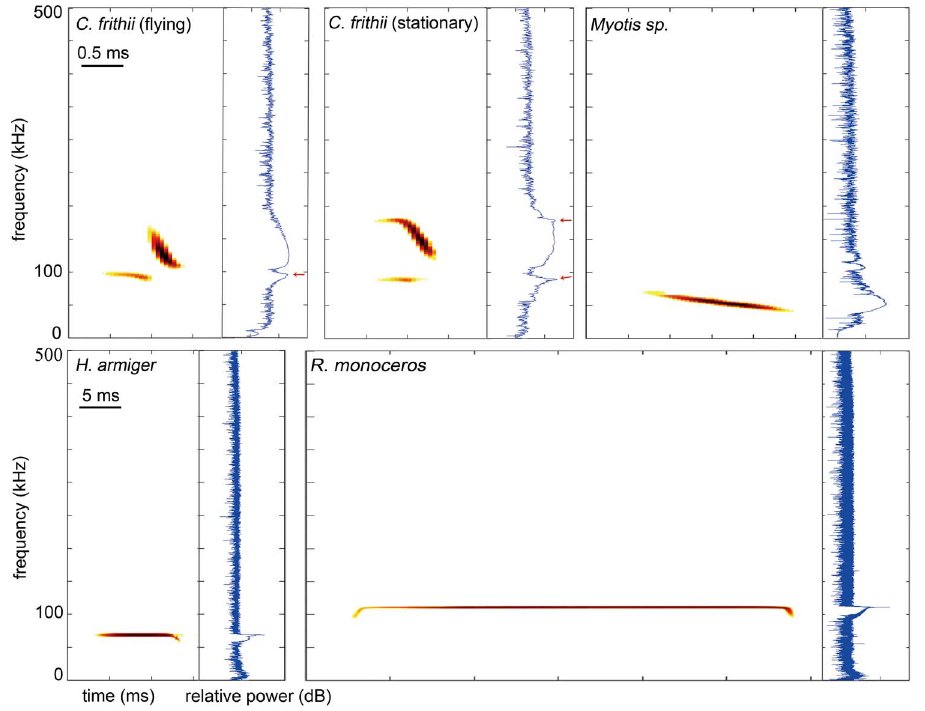
Figure 1. Spectrograms and power spectra illustrating the echolocation calls of Coelopsfrithii , Myotis sp., Hipposiderosarmiger , and Rhinolophusmonoceros . Arrows indicate the energy peak of the narrowband components of C. frithii calls. Note the time scale is ten-fold different between upper and lower rows. Short title : Echolocation call structures of Coelops frithii , Myotis sp., Hipposideros armiger , and Rhinolophus monoceros .